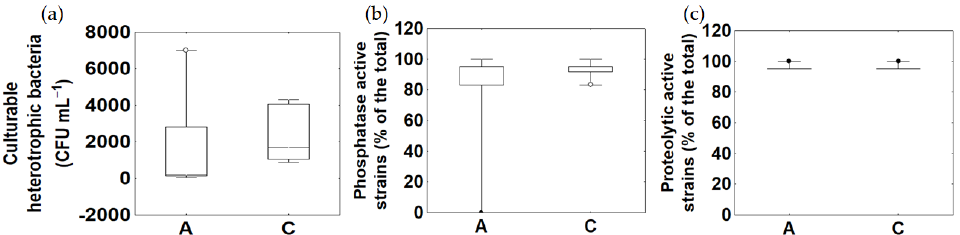
Figure 8. Box plots of the abundance of culturable heterotrophic bacteria ( a ), and of the percentages of bacterial isolates positive for proteolytic and phosphatasic activities ( b , c ). The boxes are char-acterized by a median line and boundaries indicating 25th and 75th percentiles; whiskers area characterized by a vertical line indicating 5th and 95th percentiles. White dots = outliers, black dots = extreme